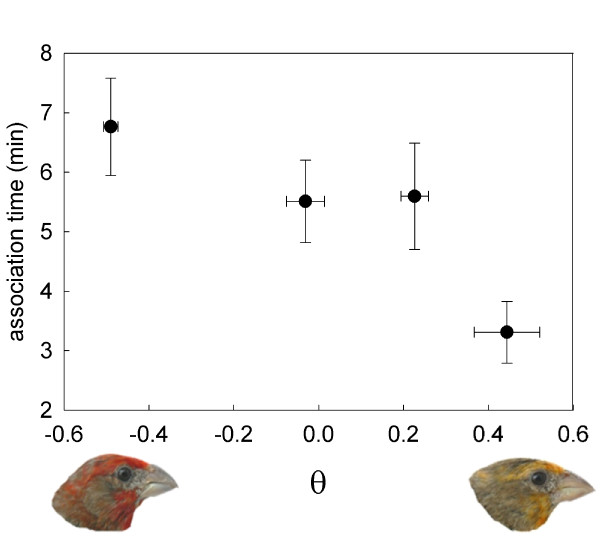
Female association times with the color-manipulated males. Mean ± s.e. association time of females with stimulus males of varying color. For presentation the males are grouped into four color categories, with the mean θ value of each category presented on the x-axis. Lower θ values indicate redder males.